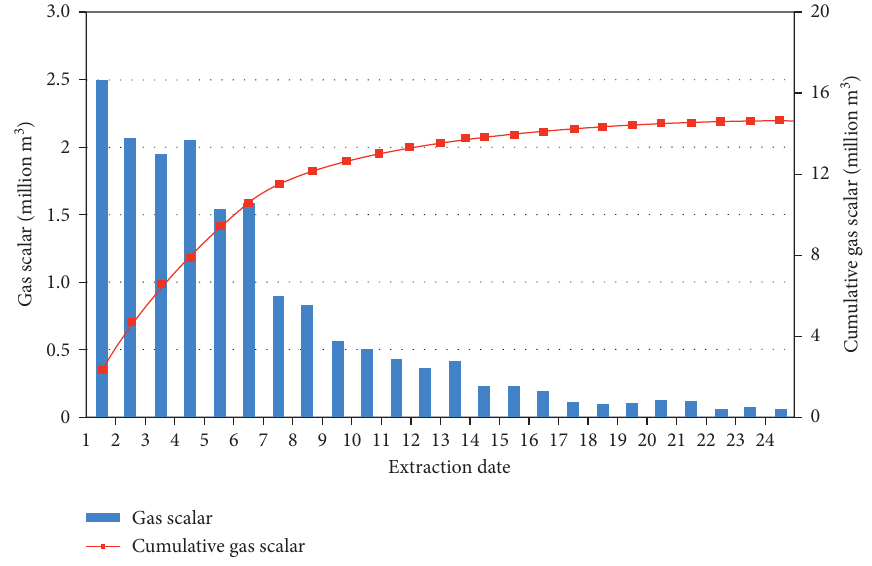
Figure 11: Gas extraction purity and cumulative extraction purity of boreholes No.